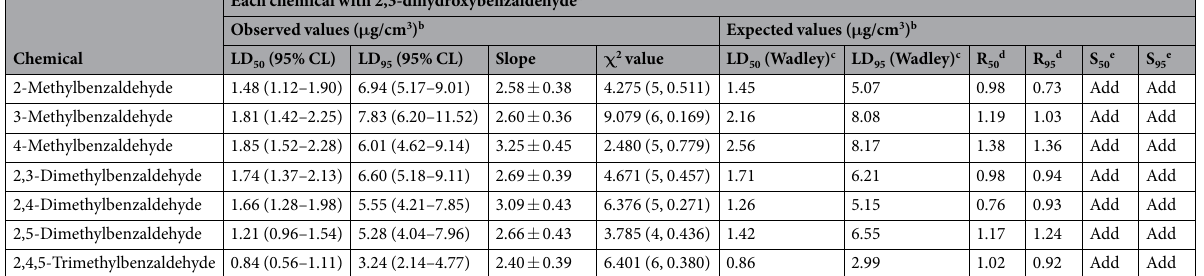
Table 6. Comparative acaricidal activity by vapor bioassays of benzaldehyde analogues with 2,3-dihyderoxybenzaldehyde against T . putrescentiae ( a Each chemical mixed at 9:1 ratio with 2,3-dihydroxybenzaldehyde. b Expected LD 50 based on Wadley’s calculation model. c Wadley’s calculation of expected LD 50 and LD 95 . d Synergy ratio from Wadley’s calculation of expected LD 50 and LD 95 . e Determination of interaction of the mixture based on Wadley’s determination method: when R > 1.5, synergistic (Syn) interaction; when 1.5 ≥ R > 0.5, additive (Add) interaction; when R ≤ 0.5, antagonistic interaction).